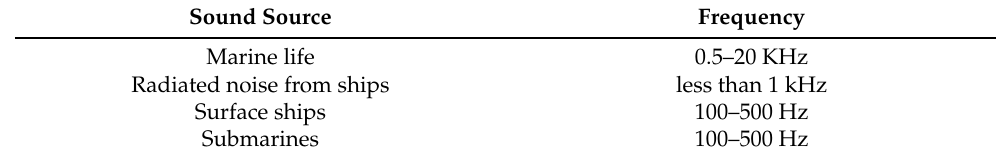
Table 1. Major ocean sound-source